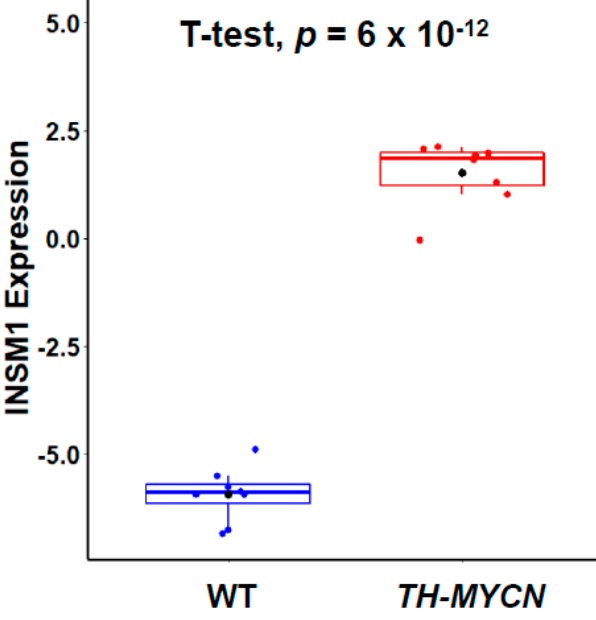
Figure 2. Insm1 expression in TH-MYCN transgenic mice. Insm1 expression in the abdominal superior mesenteric ganglion (SMG) dissected from 3-week-old TH-MYCN +/ − and WT mice. The boxplot shows the distribution and mean of Insm1 mRNA level with t test p = 6 × 10 − 12 . The expression profiling data was obtained from GSE87784 dataset.